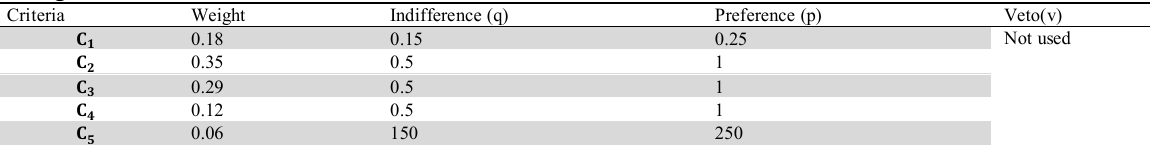
Weights and thresholds values